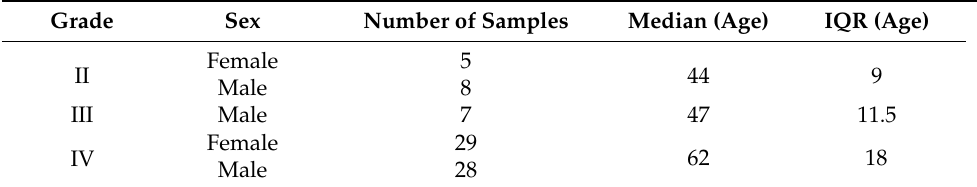
Table 1. Clinical characteristics of the samples used in the present study. Refer to the Supplementary Table S1 of ref. [23] for a description of the samples (age, sex, diagnosis, histological grade, location of each tumor). IQR, interquartile